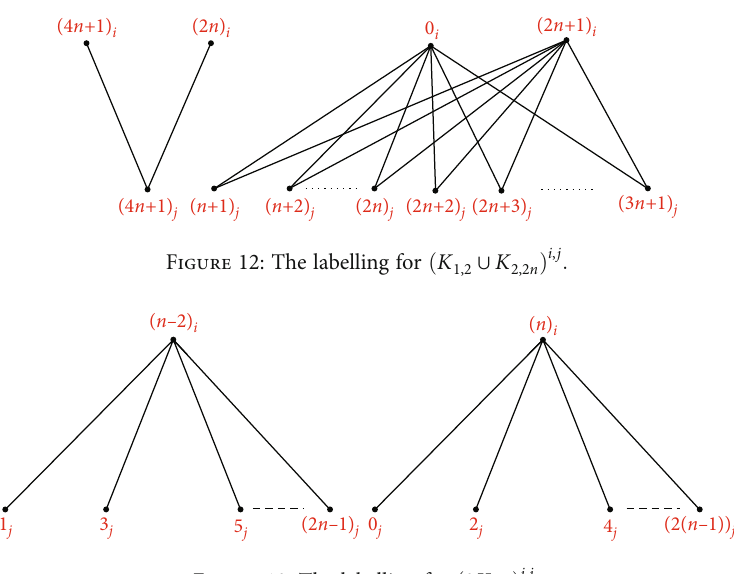
Figure 13: The labelling for ð 2 K